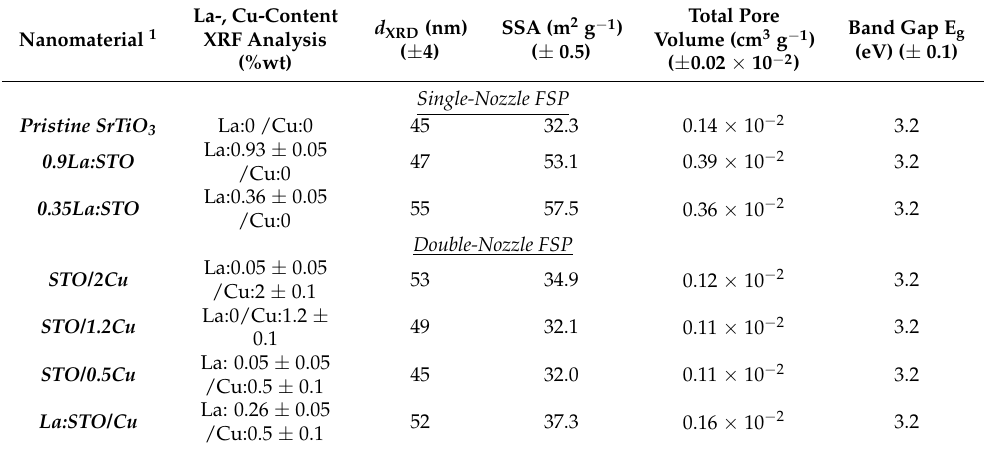
Table 1. Structural Characteristics of La:SrTiO 3 , SrTiO 3 /CuO, and La:SrTiO 3 /CuO nanoparticles.